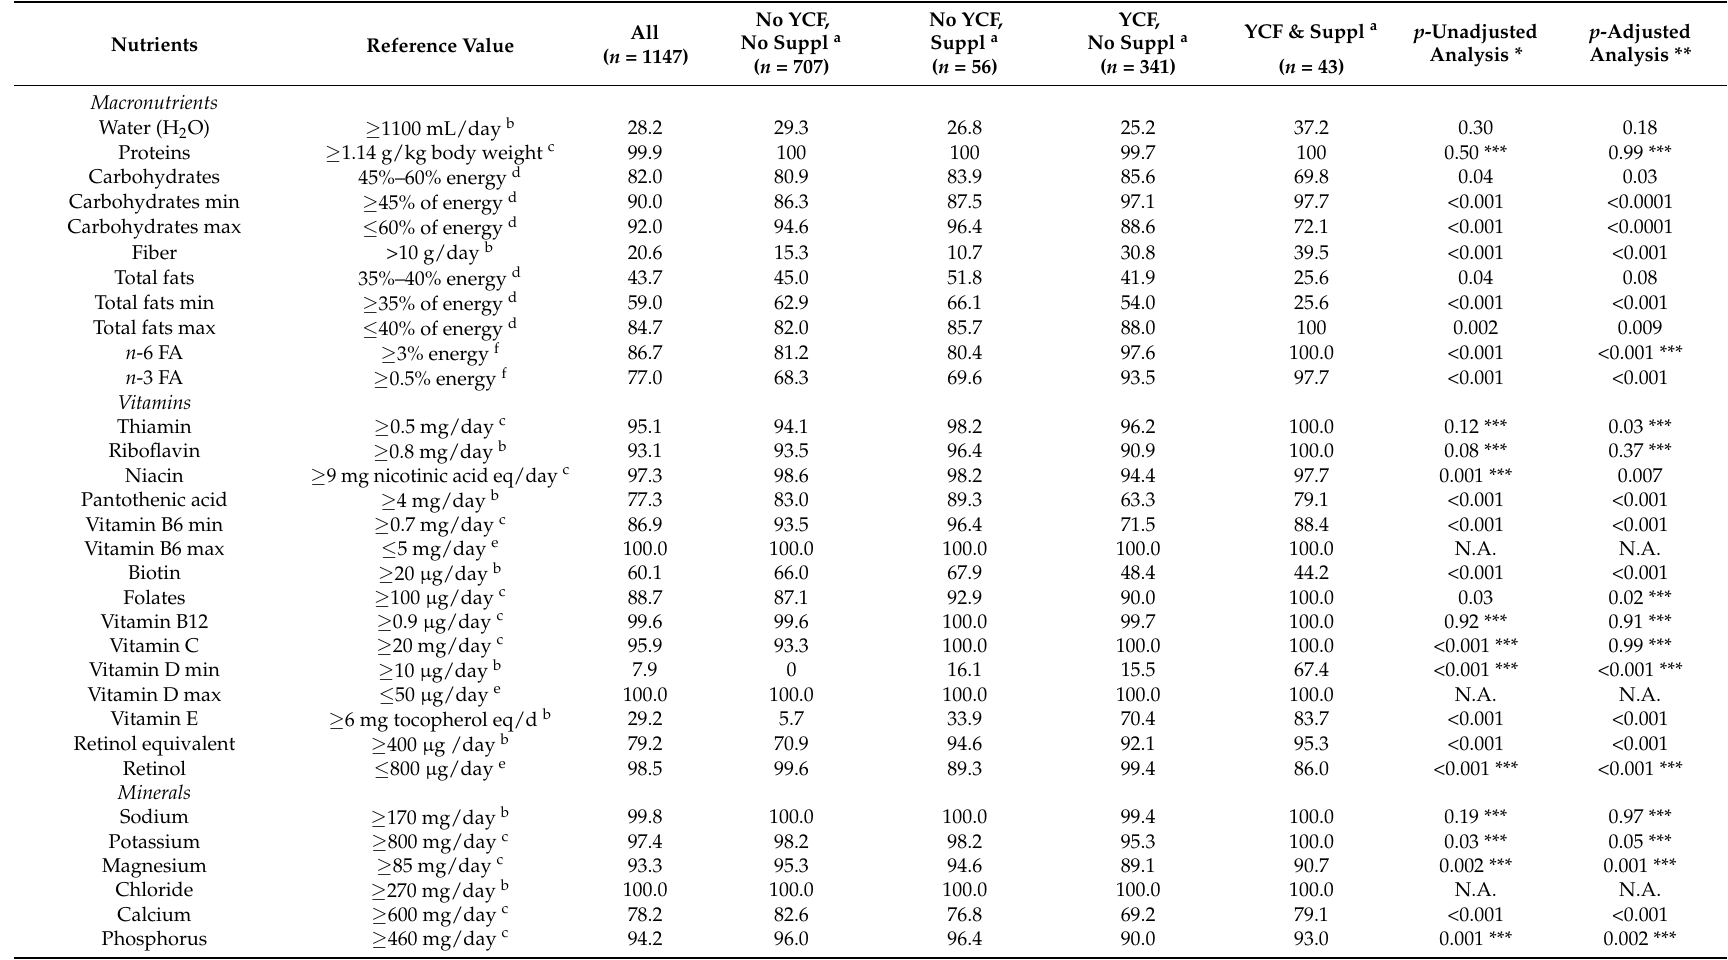
Table 2. Reference values for each nutrient, percentage of observed diets attaining each reference value (RV) for the whole sample and across the four groups of children a